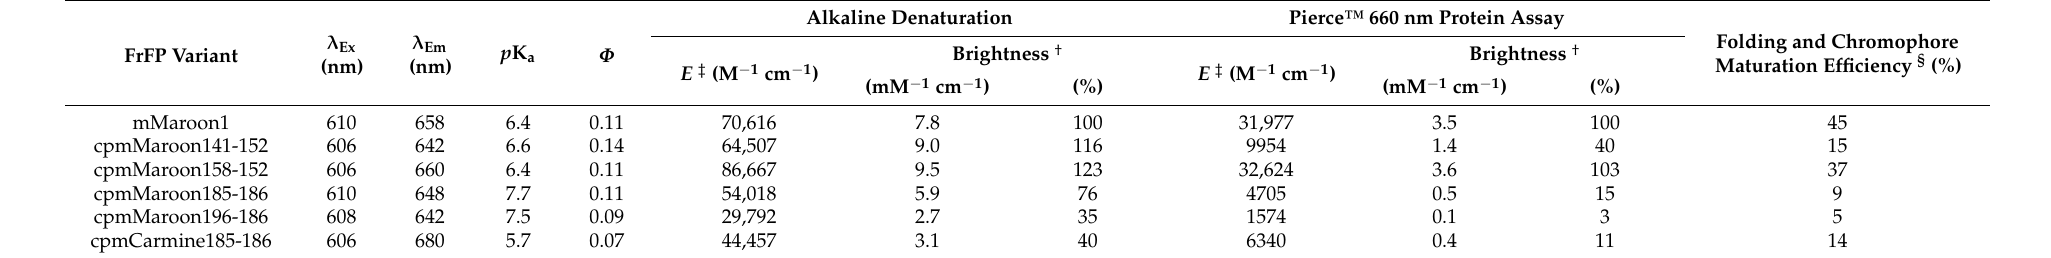
Table 1. Properties of circularly permuted mMaroon1 and mCarmine